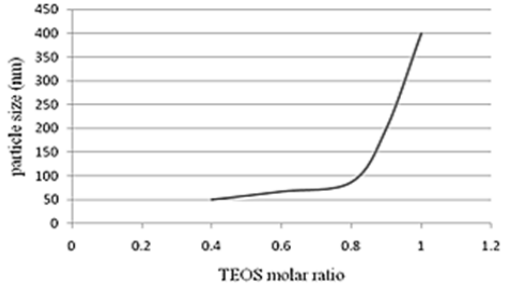
Figure 10. Particle size variation in presence of different TEOS molar ratios.